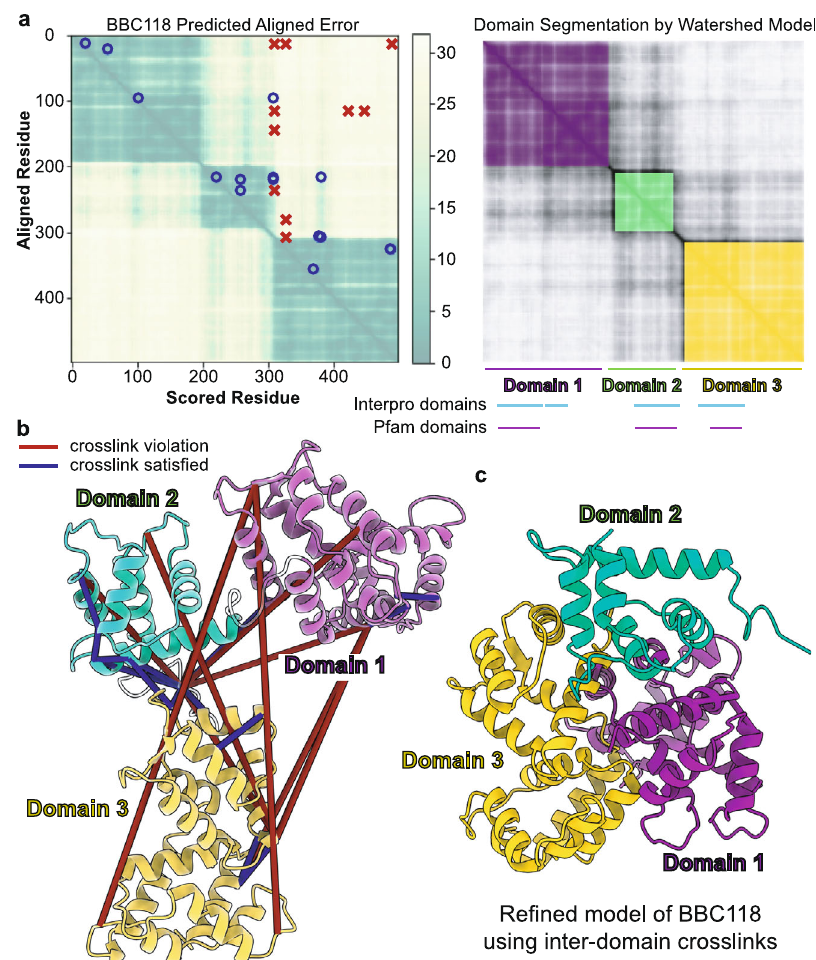
Fig. 4 Cross-link violations tend to occur between or outside of structurally well determined regions. a The predicted alignment error (PAE) 2 for T. thermophila protein BBC118 (Uniprot identi fi er I7ME23) with satis fi ed and violated cross-links plotted onto the heatmap. Blue circles are the satis fi ed cross- link and red x ’ s are the cross-link violations. b We apply a watershed model to the PAE heatmap to segment the protein into individual rigid bodies. For BBC118, all cross-link violations occur between segmented rigid bodies. c The protein rigid bodies were broken up by the segmentation from the PAE and modeled using the intramolecular cross-links as distance restraints to fi nd an arrangement that satis fi ed all but one of the cross-links. All models and PAE plots are provided at the supporting Zenodo web